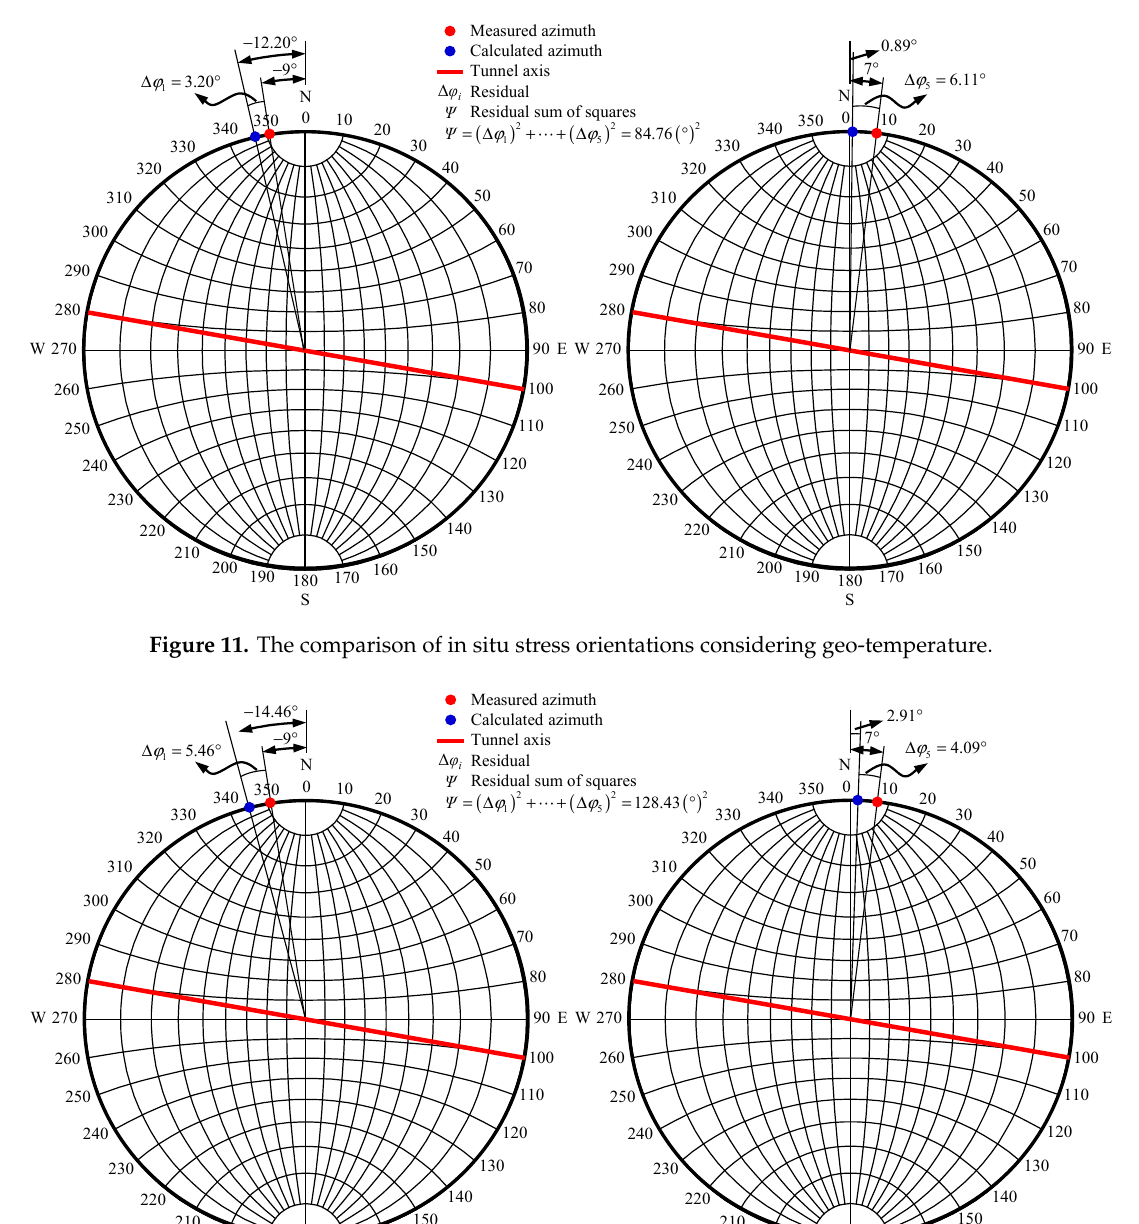
Figure 10. The comparison of the magnitude between measured in situ stresses and calculated ones.